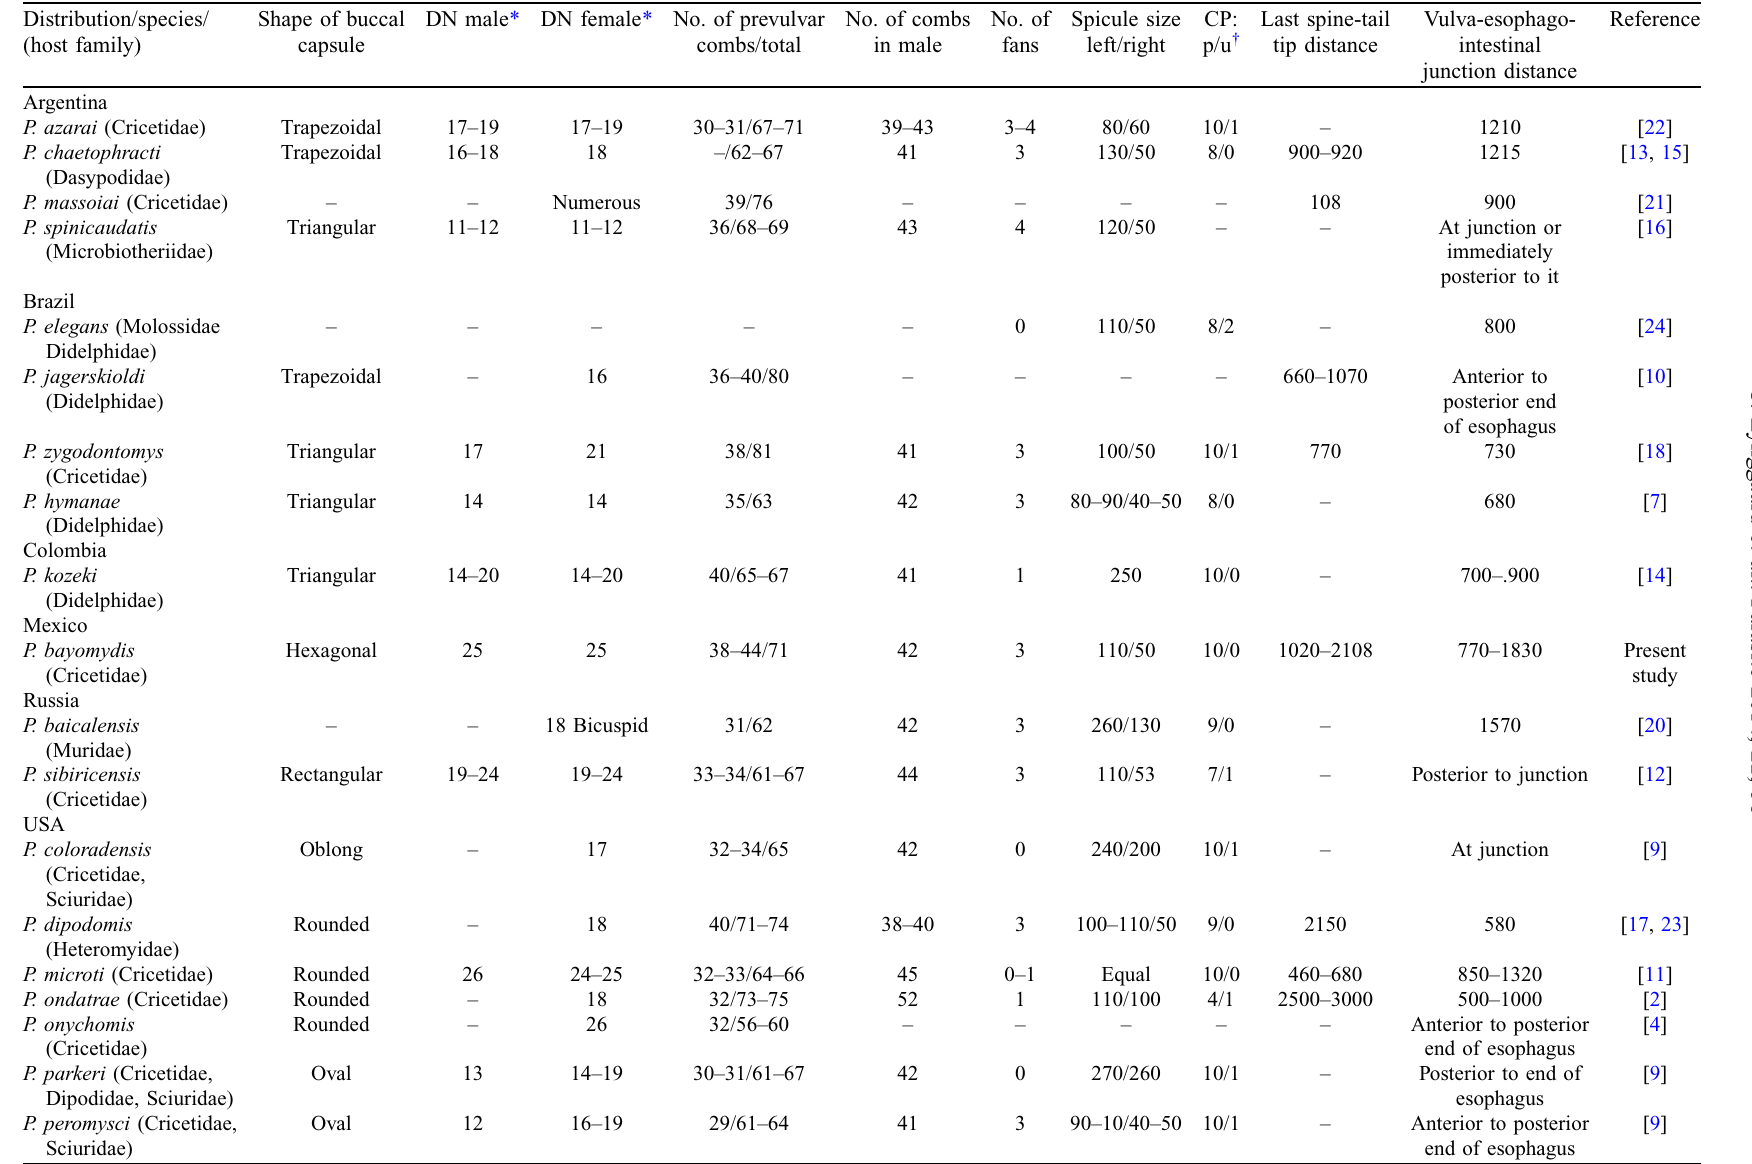
Table 1. Selected features of the species included in the subgenus Pterygodermatites ( Paucipectines ) worldwide.